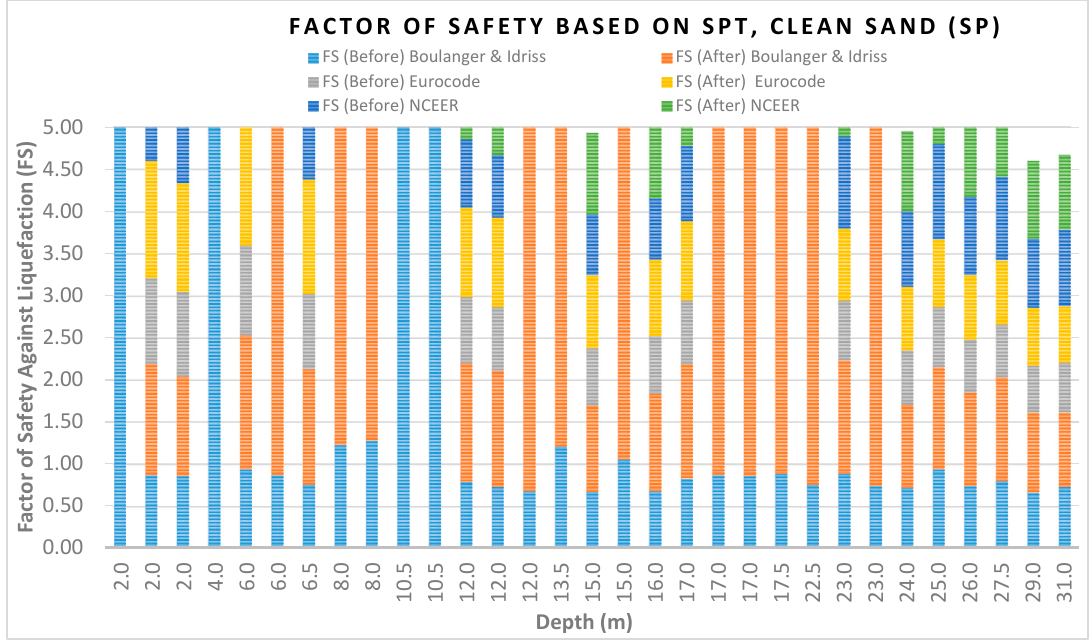
Figure 11. Comparison of the factor of safety values based on two-point moving averages, according to three CPT-based method (left) along with three SPT-based approaches (right) for assessing the improvement of the clean sand soil against the liquefaction, after jet grouting by micropiles.